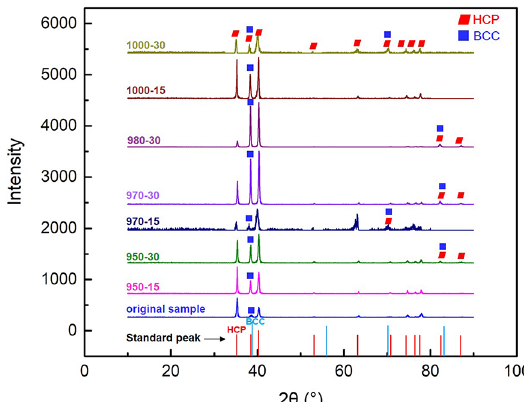
Figure 2. XRD patterns of initial and annealed Ti-5Nb-5Al alloy at different temperatures.